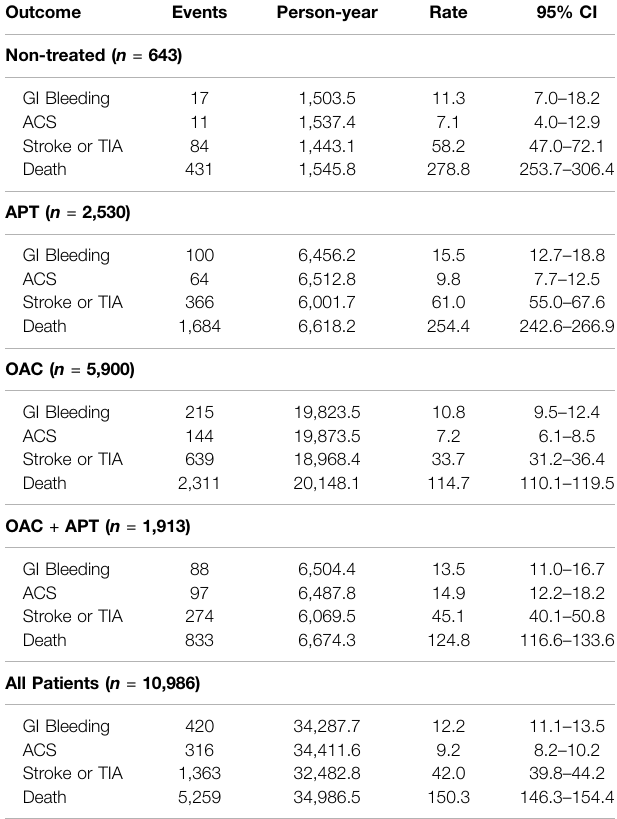
TABLE3| Incidenceratesofclinicaloutcomesinpatientswithatrial fi brillationwho survived a stroke, by treatment strategy. Outcome